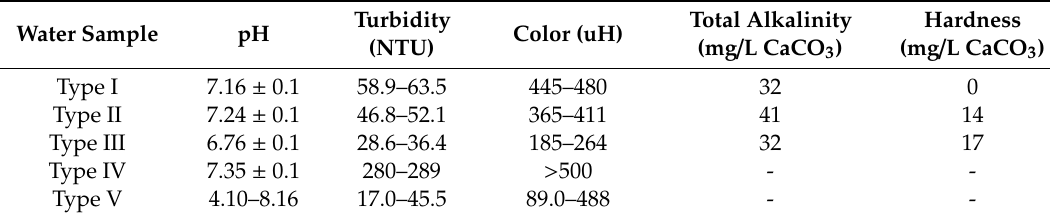
Table 3. Water sample